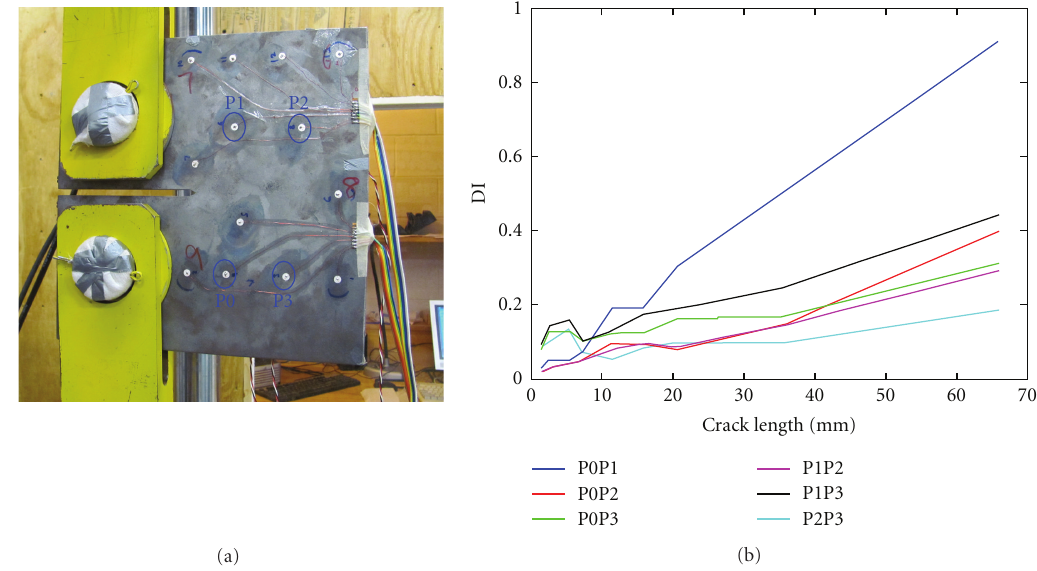
Figure 11: AE detection on a 1/2 (cid:4)(cid:4) CT specimen. (a) Geometry of the specimen and arrangement of transducers; (b) a snapshot of the actual specimen. AE PWAS are circled (rest are for active sensing). The R15I was installed on the other side of the specimen.